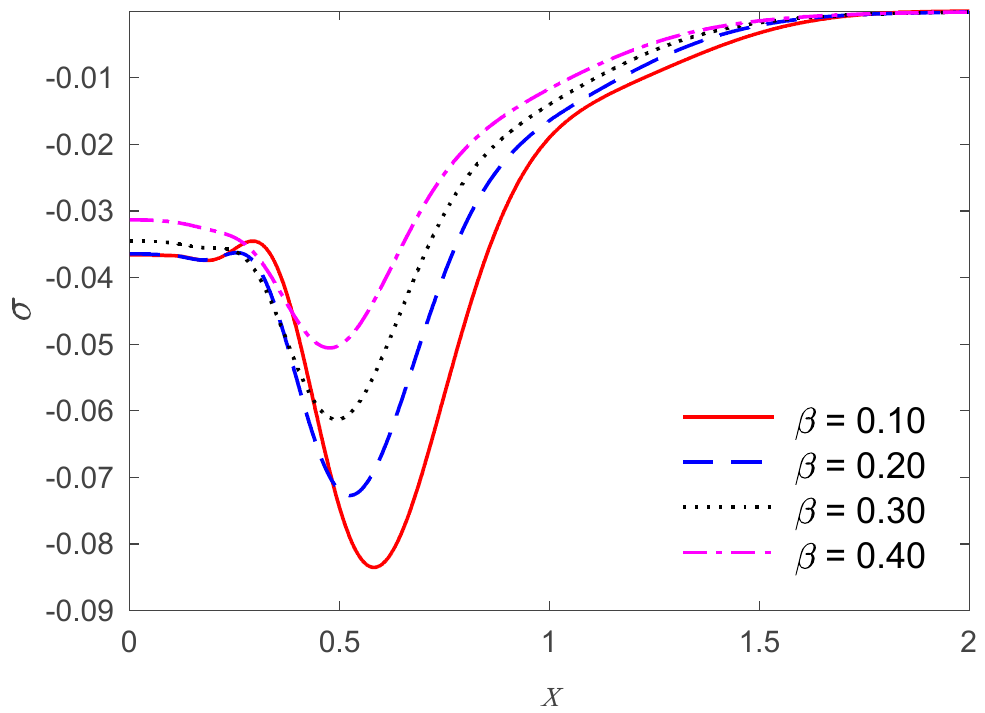
Figure 11. The effects of porosity on the fluid stress variations.